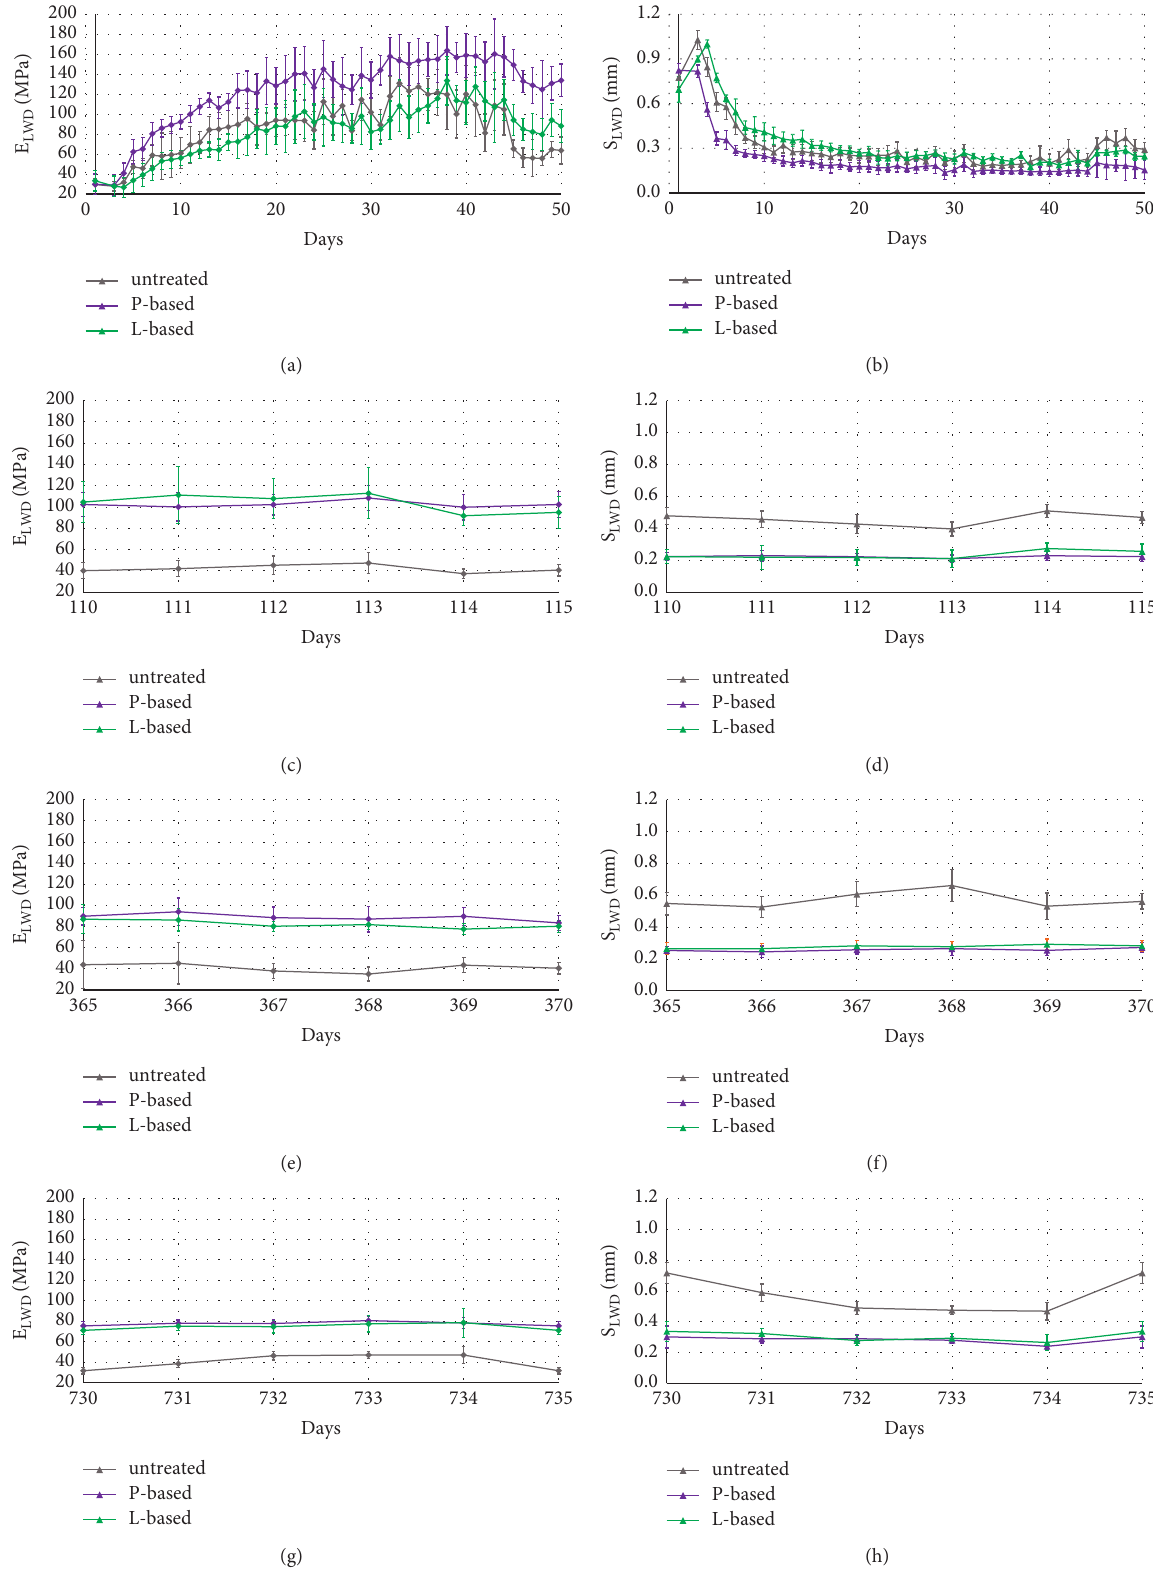
Figure 12: Resilient modulus E LWD (a, c, e, g) and settlement S LWD (b, d, f, h) for day 1–day 50, day 110–day 115, day 365–day 370 [24] and day 730–day